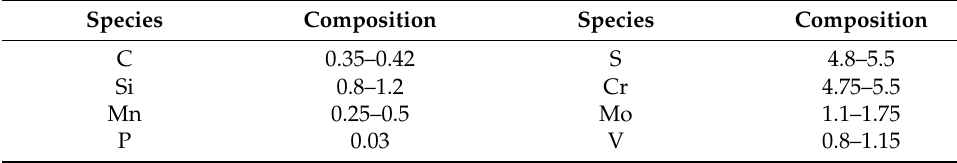
Table 2. Main chemical composition of SKD61.